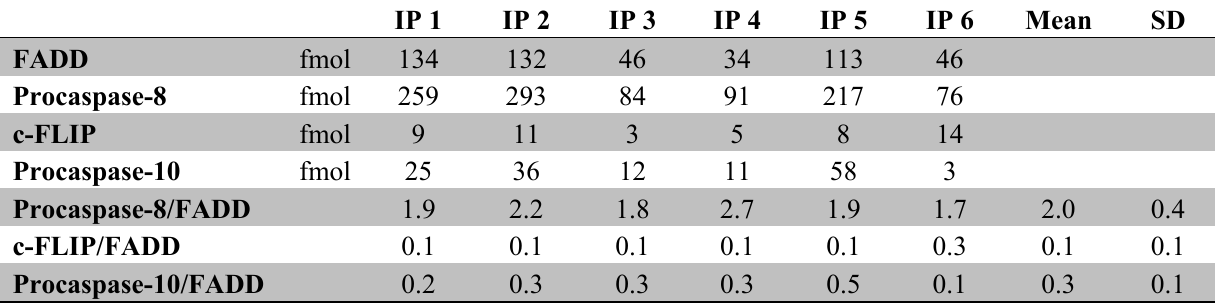
Table 3. Absolute amounts of FADD, procaspase-8, c-FLIP and procaspase-10 detected in DISC IPs after stimulation of SKW6.4 cells with 1 µg/mL LZ-CD95L. The ratios of DISC proteins normalized to FADD are given